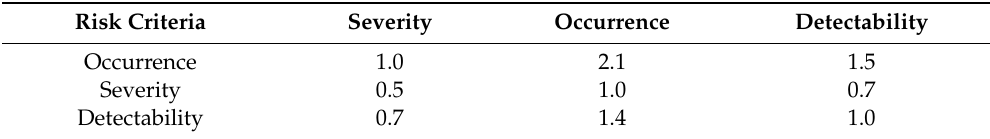
Table 10. Relative importance of risk factors in comparison by